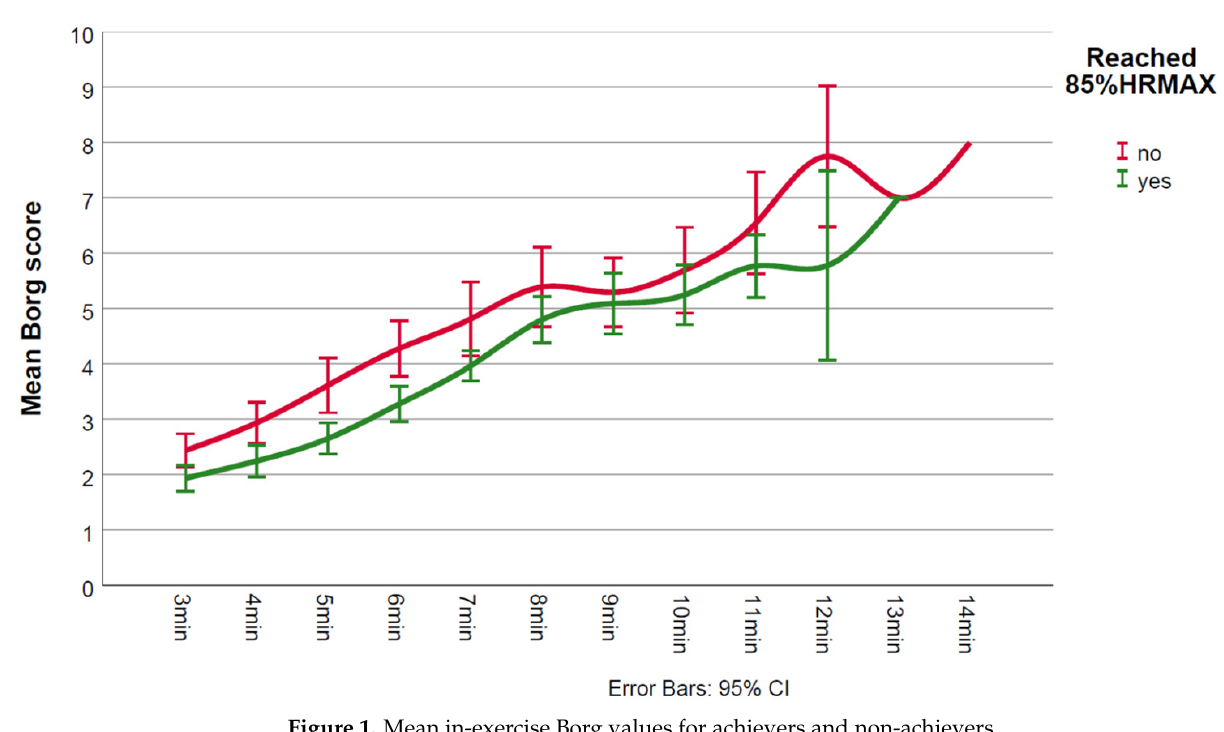
Figure 1. Mean in-exercise Borg values for achievers and non-achievers.